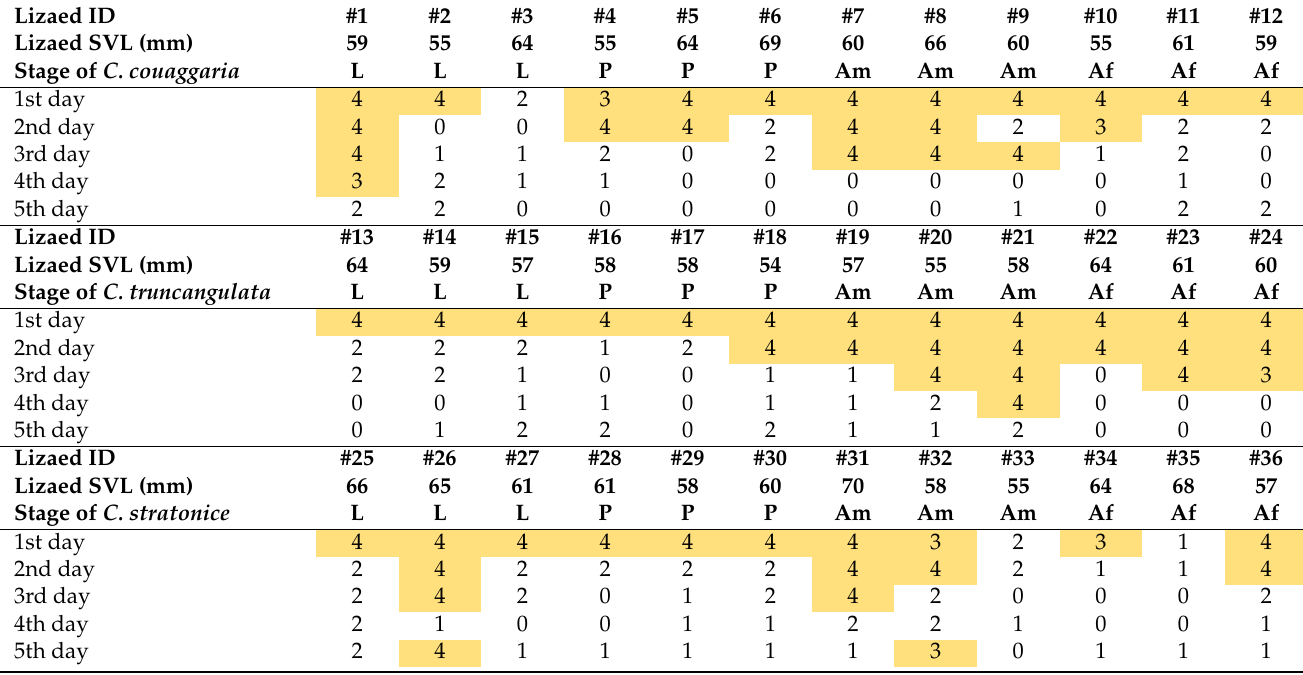
Table 2. The lizard feeding behaviors in the five-day feeding trials of individual lizards (#1–36), when given larvae (L), pupae (P), adult males (Am), and adult females (Af) of the three species of Cystidia moths: C. couaggaria , C. truncangulata , and C. stratonice . Feeding behavior is shown by the six sequences to which lizards reach: no response (0), heading toward prey (1), licking prey (2), pecking prey with their mouthparts (3), biting prey but immediately releasing it (4), swallowing prey but regurgitating it (5), and complete feeding (6). Categories (5) and (6) are not observed, and more active responses (3) and (4) are shaded. SVL shows the lizard snout to vent length in